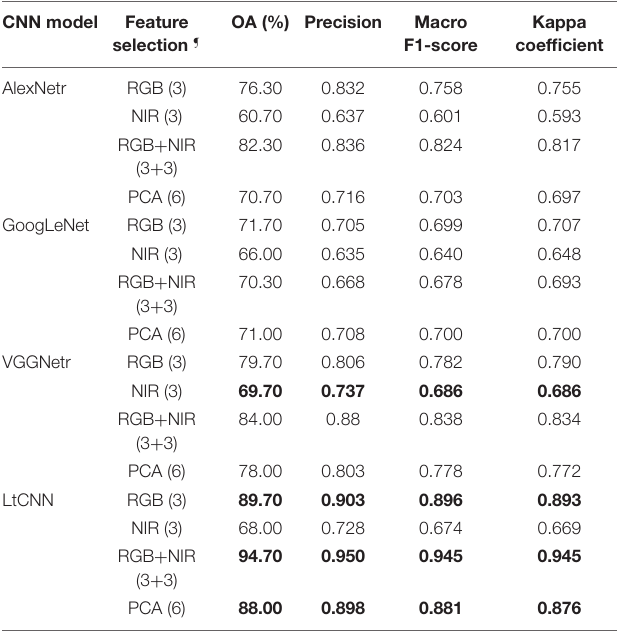
TABLE 5 | Classification performance of different CNN models applied to different feature selection